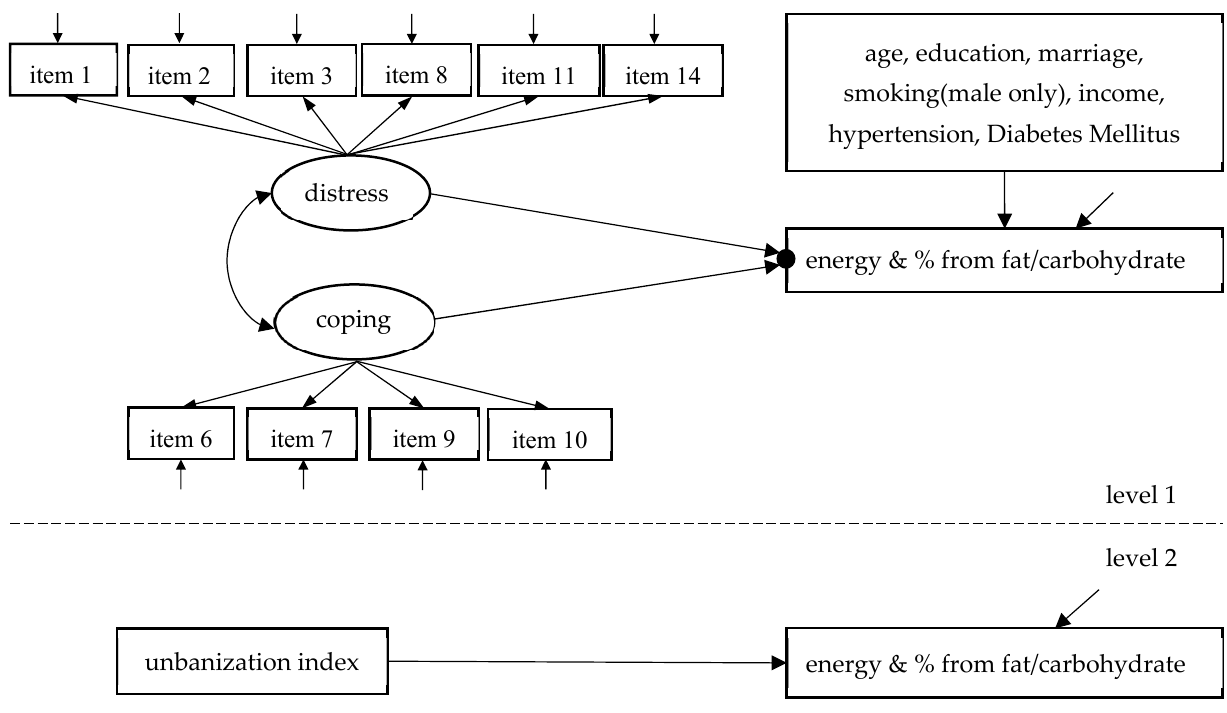
Figure 1. Combined two-level mixed effects and structural equation modeling of the effects of distress factor and coping capacity factor on the intake of energy and percentage of energy from fat and carbohydrate.